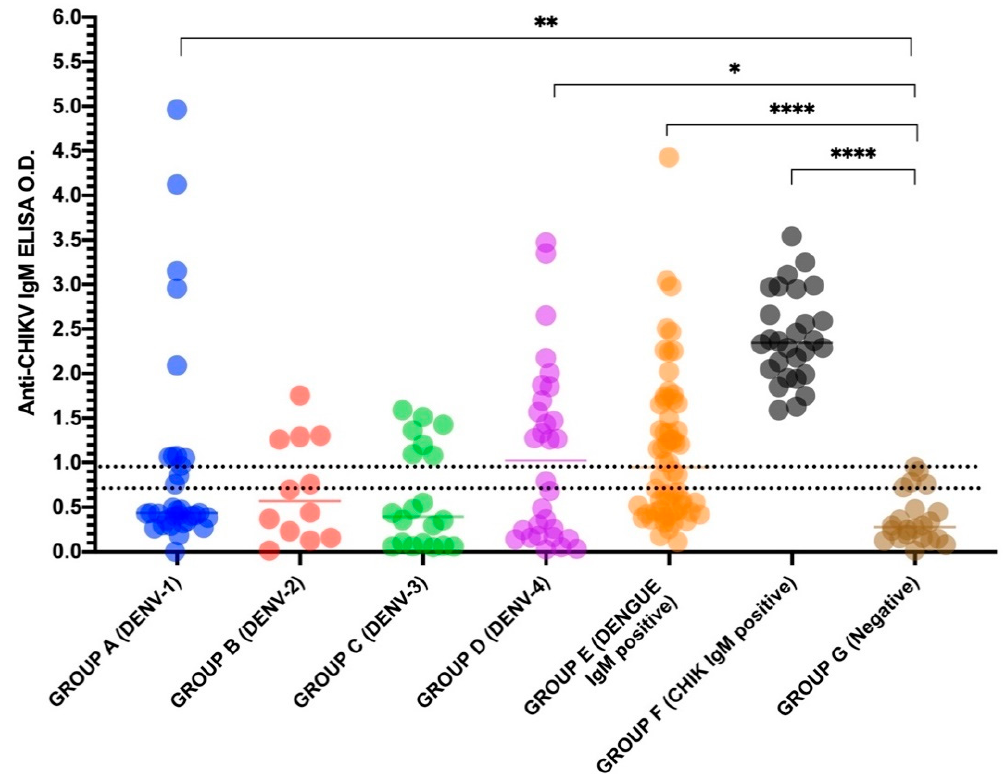
Figure 1. Absorbance values obtained using the Anti-chikungunya IgM ELISA test (Euroimmun) on a panel ( n = 340) of dengue, chikungunya and controls. The nonparametric Mann–Whitney U test was used to evaluate differences between optical density (OD) among the dengue and chikungunya groups (Groups A–F) in comparison to the healthy individual group (Group G). **** p < 0.0005, ** p < 0.005, * p < 0.05, (-) represents the mean value for each group and (—) dashed lines, the cut-off interval for the test. The negative (<0.8) and positive (>1.1) cutoff values were determined at a wavelength of 450 nm and a reference value between 620 nm and 650 nm.